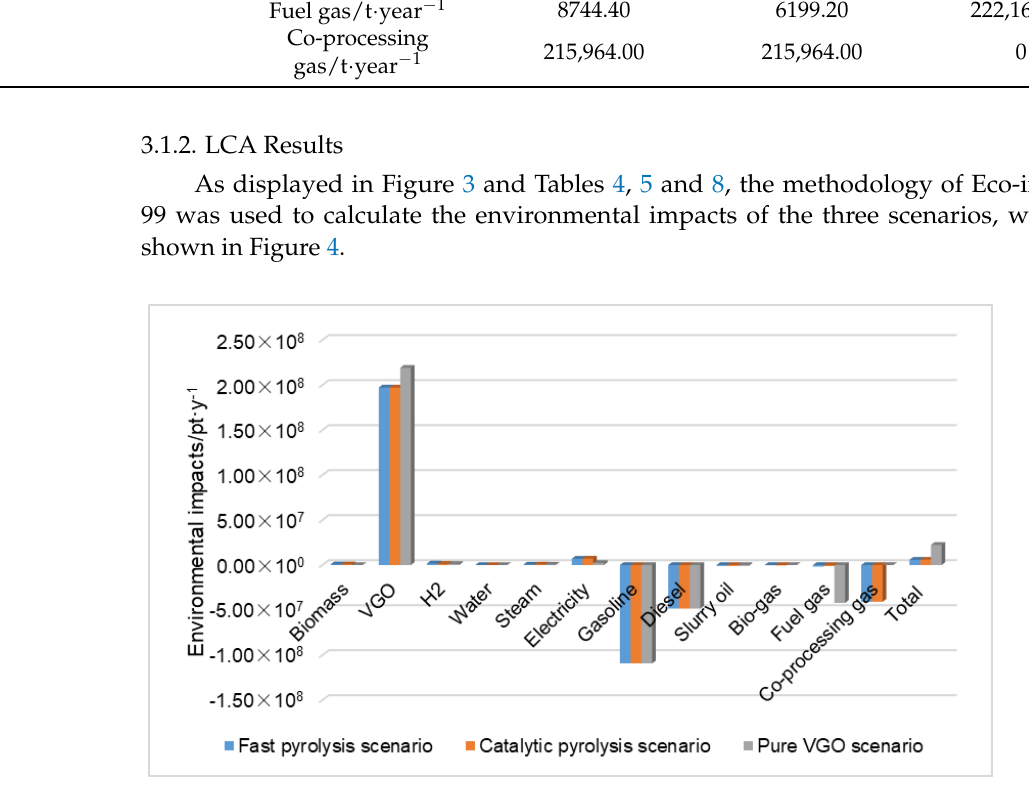
Figure 4. Environmental impacts of the three scenarios in Case 1.